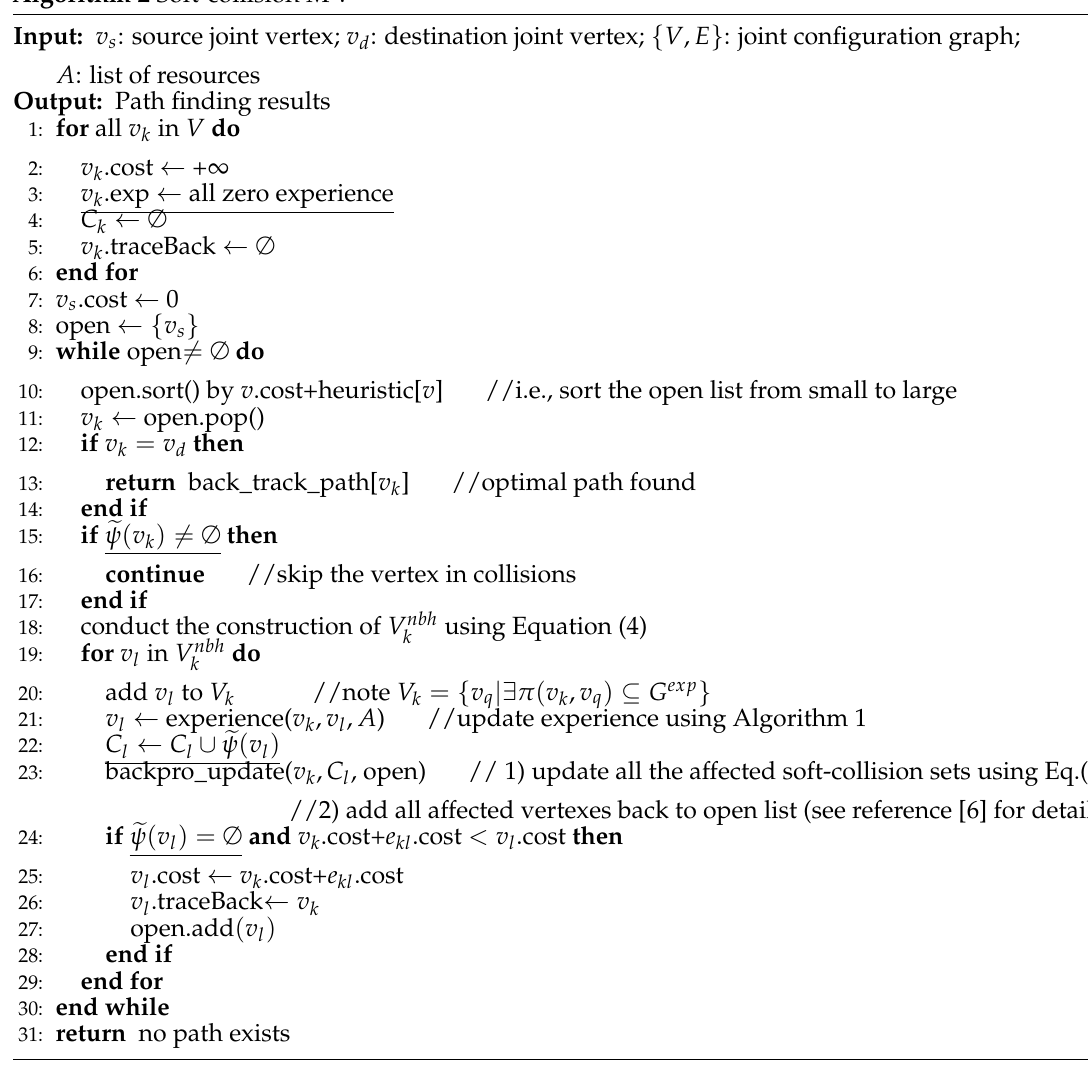
Algorithm 2 Soft-collision